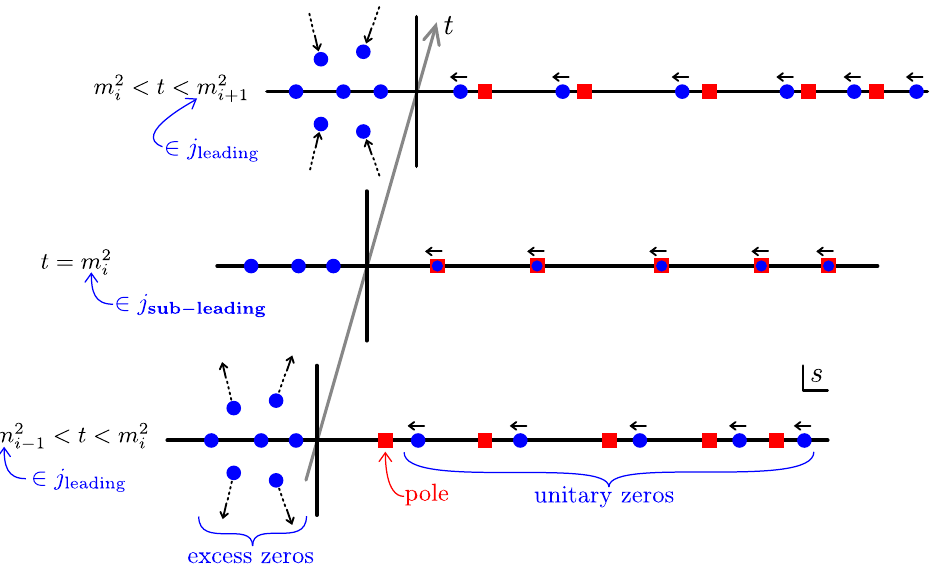
Figure 4 . The behavior of excess zeros z ( e ) ( t ) as we change t . As we cross the poles of the sub- i leading Regge trajectories, some of the zeros escape to infinity and come back to the unit disk. This effect due to non-degeneracy of the spectrum is responsible for the non-zero support of the excess zeros distribution outside of the unit